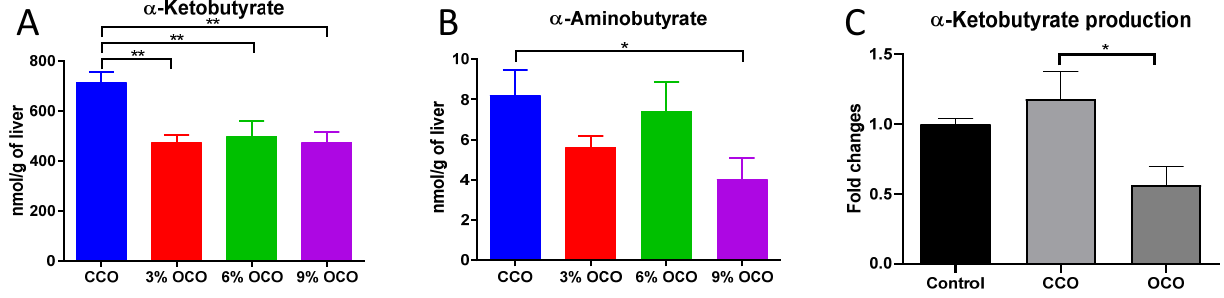
Figure 6. Effects of dietary concentrations of oxidized corn oil (OCO) on the hepatic metabolites of threonine catabolism. ( A ) Concentrations of α -ketobutyrate. ( B ) Concentrations of α -aminobutyrate. ( C ) Production of α -ketobutyrate after the in vitro incubation of pig liver homogenate with the polar extracts of control corn oil (CCO) and OCO. The extraction solution was used as the control. The production rate of α -ketobutyrate in the control was artificially set as 1, and the production rates in the coincubation of CCO and OCO extracts with pig liver homogenate samples were expressed as the fold of changes compared to the control. Value = mean ± SEM (n = 3 replicates per reaction). * p < 0.05 and ** p < 0.01 from one-way ANOVA followed by the Tukey post hoc test between the CCO and OCO dietary treatments.